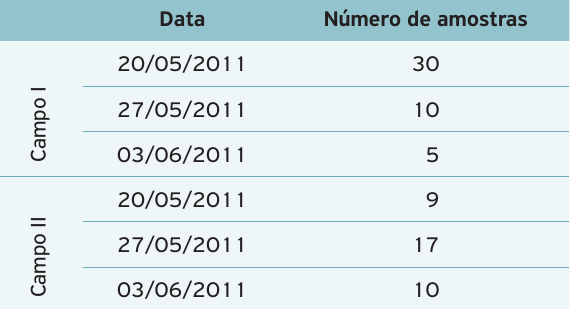
Tabela 3. Número de amostras de Empoasca kraemeri , obtidas pela equação proposta por Kogan e Herzog (1980) com um índice de precisão de 25%. Fortaleza, Ceará, 2011.